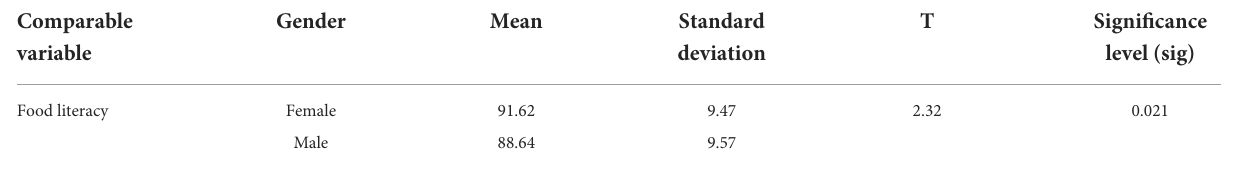
TABLE 3 Mean comparison test of food literacy in terms of gender. Comparable